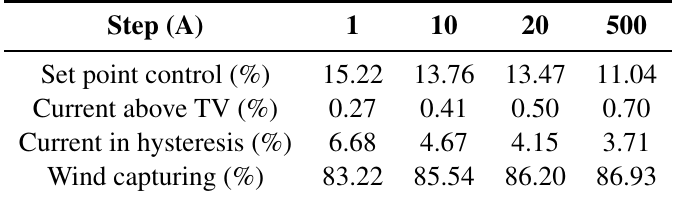
Table 7. Simulation results: stepwise relief of the control action and the effect of the parameter